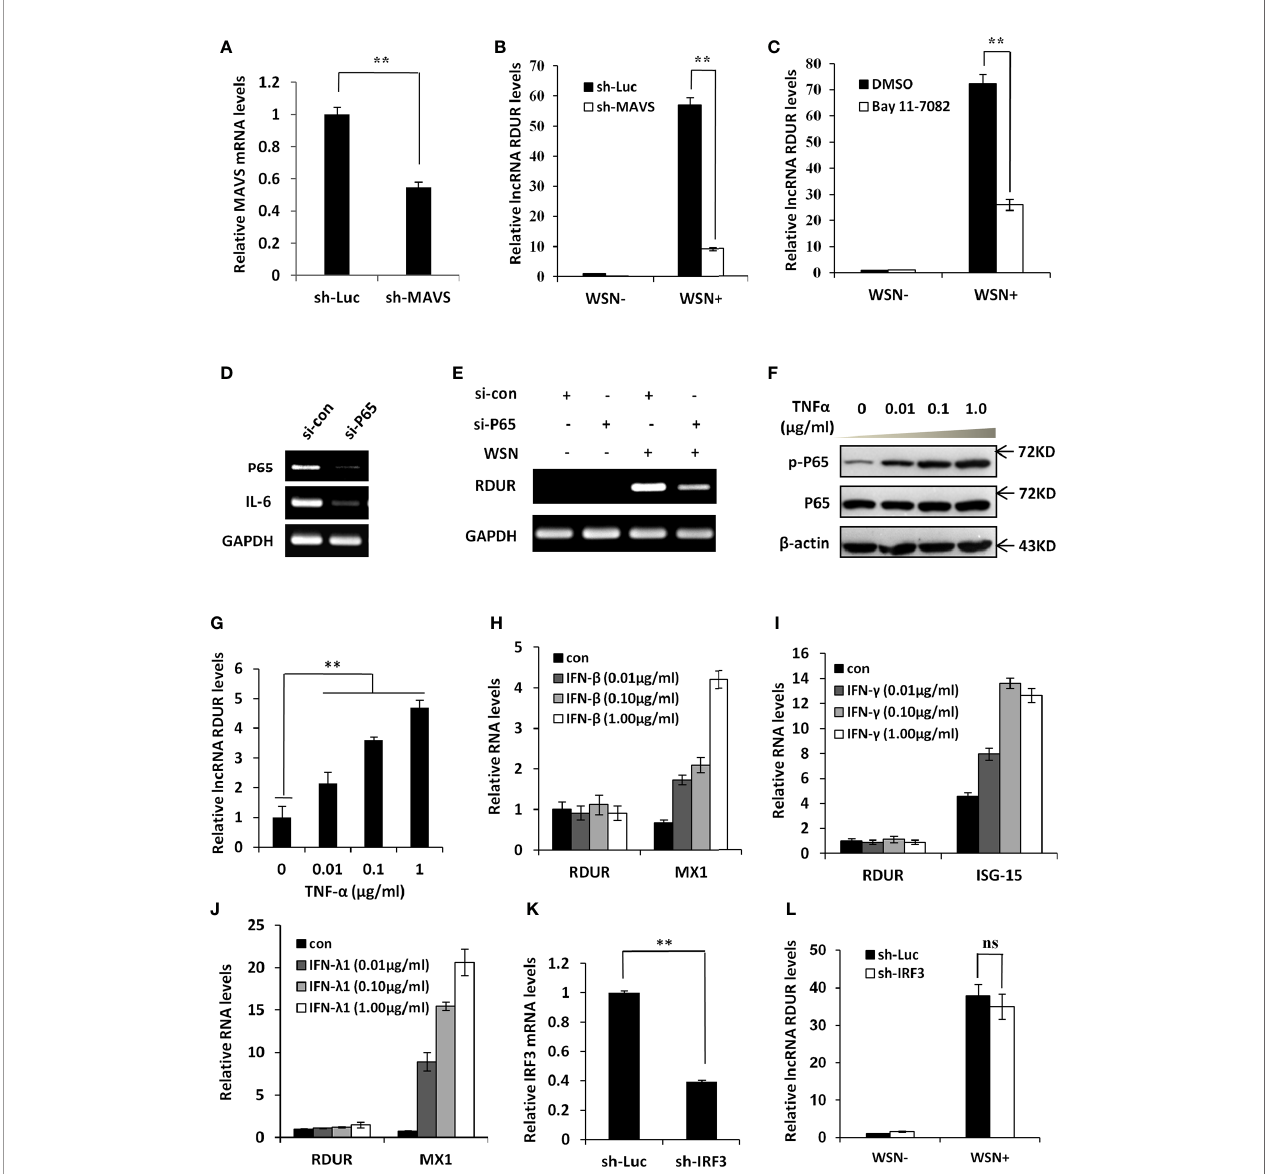
FIGURE 4 | IAV-induced RDUR expression is regulated by NF- k B but not IRF3 and IFNs. (A) sh-MAVS and sh-Luc (control) infected A549 cells were analyzed by qRT-PCR to determine the interference ef fi ciency. (B) The RNA levels of RDUR in sh-MAVS and sh-Luc (control) A549 cells infected with or without WSN were determined by qRT-PCR. (C) The RNA levels of RDUR in A549 cells treated with or without Bay 11-7082 and infected with or without WSN were determined by qRT-PCR. (D, E) A549 cells were transfected with siRNAs targeting NF- k B (P65/NFKB3) or control siRNA for 36 h and infected with WSN for 16 h. The knockdown ef fi ciency (D) and the RNA level of RDUR (E) were then detected by RT-PCR. (F, G) A549 cells were stimulated with TNF- a for 180 min, and the activation of NF- k B was con fi rmed by Western blotting (F) and the expression of RDUR was examined by qRT-PCR (G) . (H, J) A549 cells were treated with different amounts of IFNs including IFN- b (H) , IFN- g (I) and IFN- l 1 (J) for 90 min. The expression levels of RDUR and ISGs (Mx1 or ISG15) in the cells were examined by qRT-PCR. (K) Shown is IRF3 (sh-IRF3) knockdown ef fi ciency analyzed by qRT-PCR in A549 cells. (L) The RNA levels of RDUR in sh-IRF3 and sh-Luc A549 cells infected with or without WSN were determined by qRT-PCR. Shown are representative data from three independent experiments. Plotted are the average levels from three independent experiments. The error bars represent the SD, ** P < 0.01, and ns represents no statistical signi fi